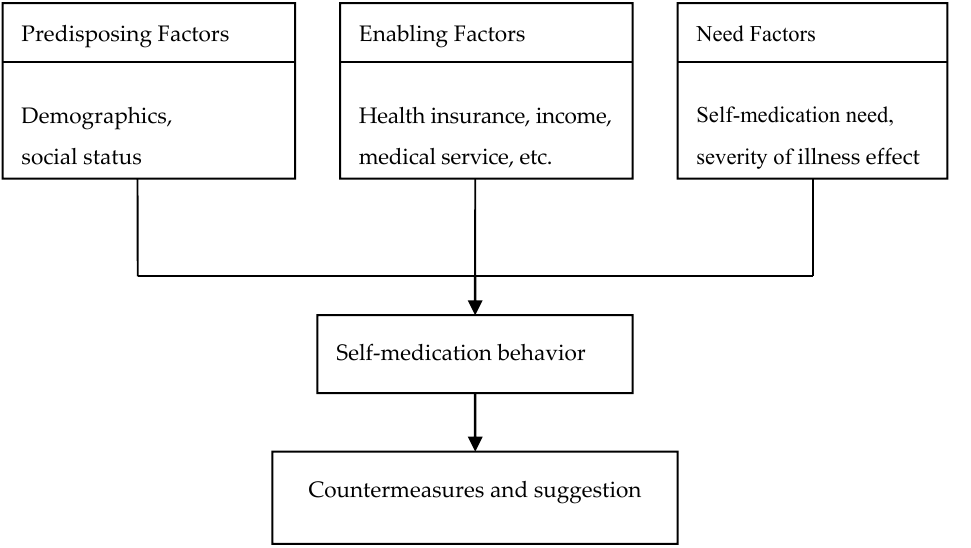
Figure 1. Conceptual framework of the modified Andersen model of health service utilization.